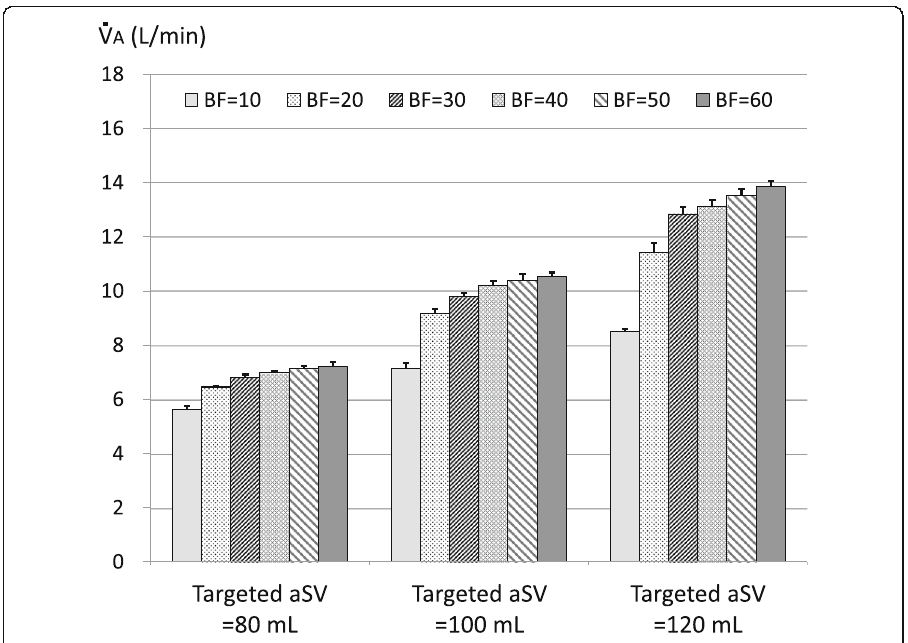
Fig. 6 Alveolar ventilation ( _ VA) measured with targeted actual stroke volume (aSV) of 80, 100, and 120 mL. Legend: Bar graph indicates mean _ VA ( n = 5), and vertical bar indicates standard deviation. The results of statistical significance test are as follows: BF = 10 vs BF = 20 – 60: P < 0.001 with all aSV; BF = 20 vs BF = 30 – 60: P <0.001 with all aSV; BF=30 vs BF=40: ns with aSV=80 and 120, P <0.05 with aSV=100; BF=30 vs BF=50: P <0.01 with aSV=80 and 120, P <0.001 with aSV=100; BF=30 vs BF=60: P <0.001 with all aSV; BF=40